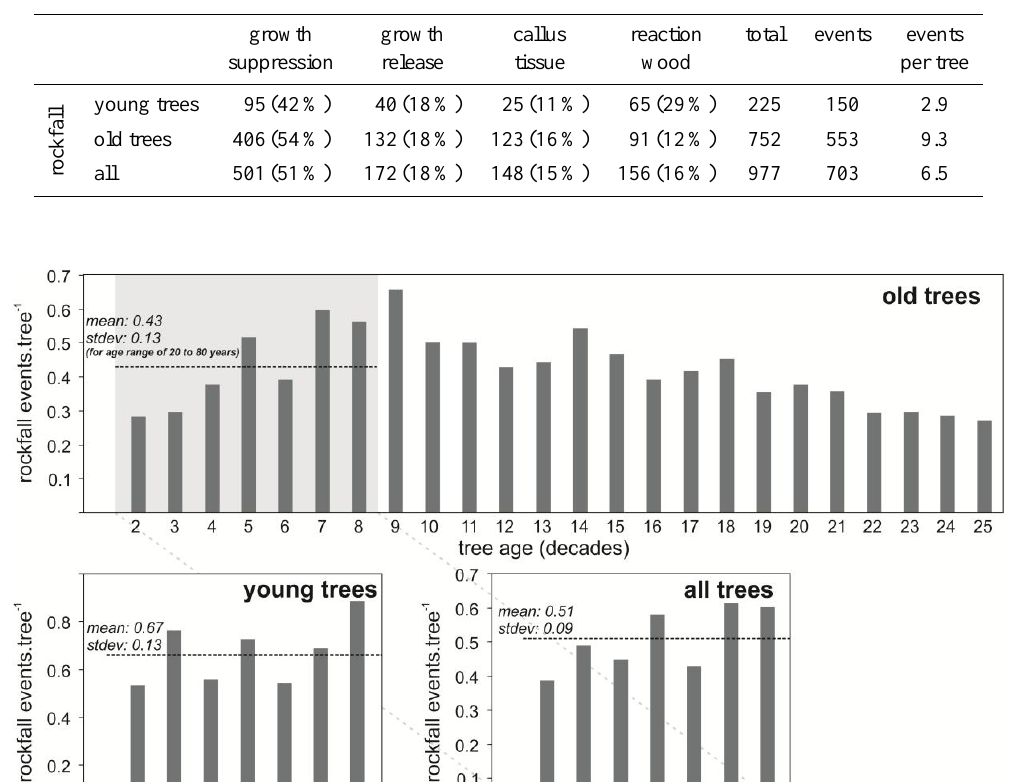
Table 1. Dated growth disturbances and number of events from both group of trees.